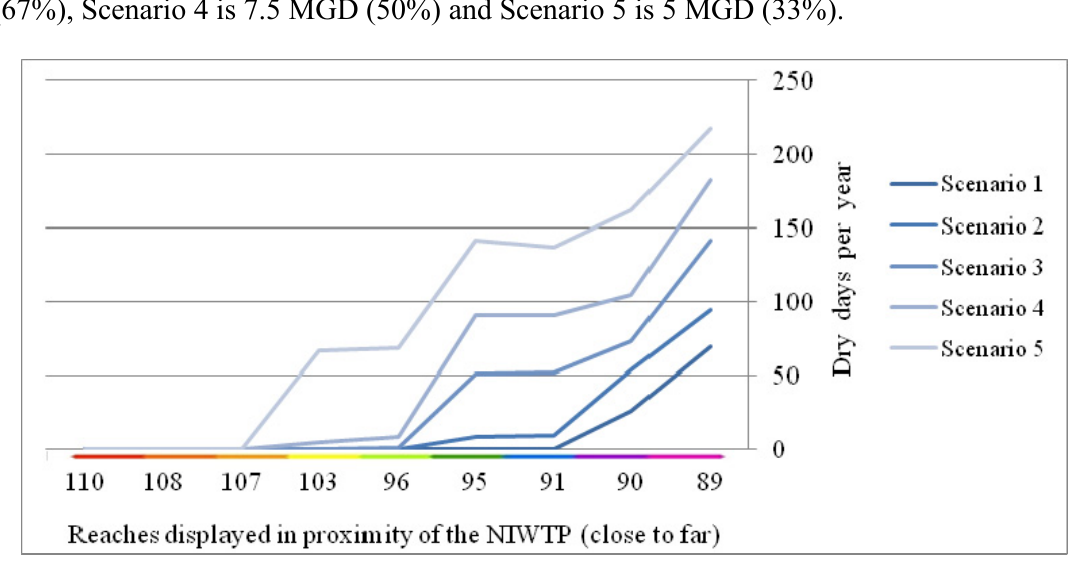
Figure 5. Line graph displaying the number of dry days per year that is predicted at each reach, with varying effluent release scenarios [49], where Scenario 1 is current day or 15 million gallons per day (MGD), Scenario 2 is 12.5 MGD (83%), Scenario 3 is 10 MGD (67%), Scenario 4 is 7.5 MGD (50%) and Scenario 5 is 5 MGD (33%).